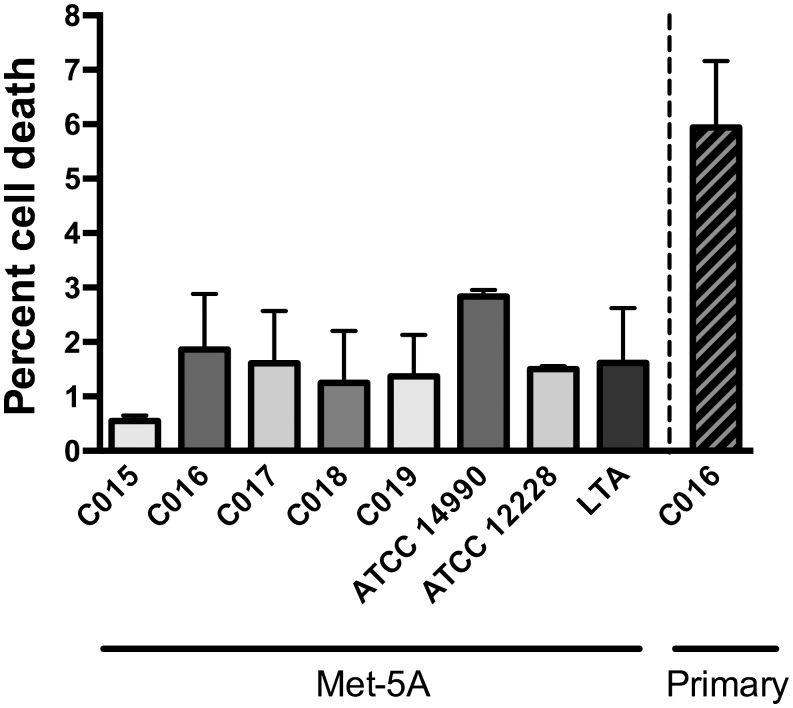
Viability of Met-5A and primary mesothelial cells exposed to S. epidermidis and lipoteichoic acid.Confluent Met-5A mesothelial cells were exposed to 107 cfu/mL of two S. epidermidis reference isolates (ATCC® 14990 and ATCC® 12228), five S. epidermidis clinical isolates from PD peritonitis patients (C015, C016, C017, C018, C019) and 10 μg/mL lipoteichoic acid (LTA) for 1 hour at 37°C. Confluent primary mesothelial cells were exposed to 107 cfu/mL of the clinical S. epidermidis isolate C016. Viability was determined using flow cytometry and a LIVE/DEAD® Fixable Near-IR Dead Cell Stain, and data reported as the mean percentage of cell death across a minimum of biological triplicates (error bars are standard deviation). There was no statistically significant (p < 0.05) difference in the percent of cell death between any of the samples and the media control.